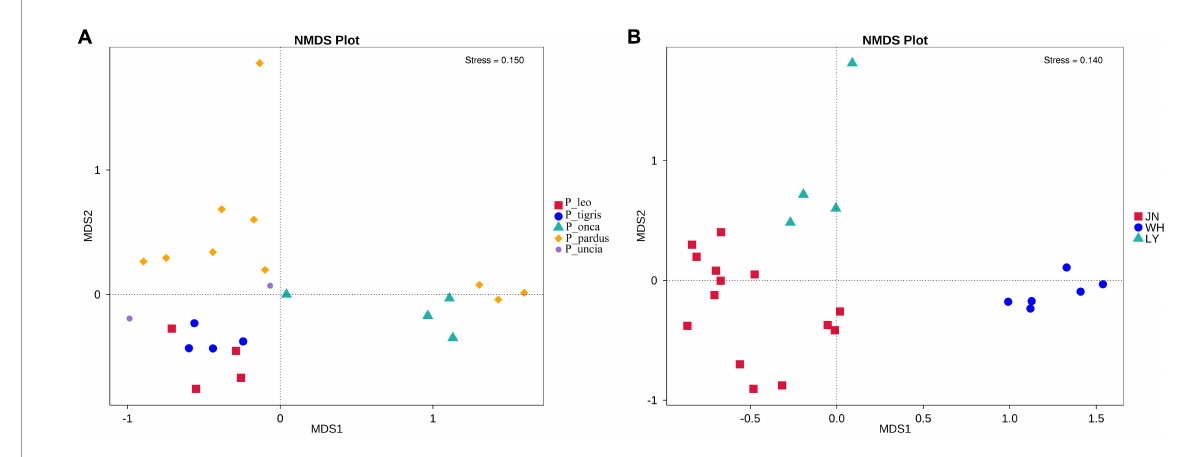
FIGURE1 NMDS analysis of fecal microbiota among species groups (A) and sampling location groups (B) .